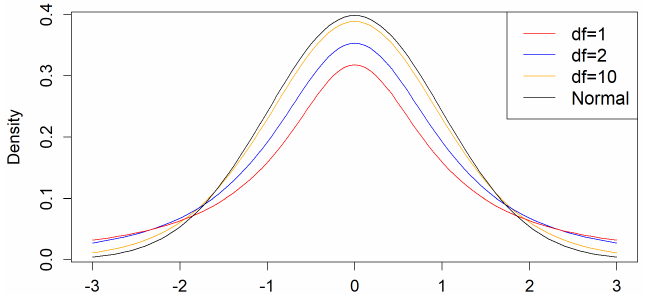
Figure 1. Normal and Student − t